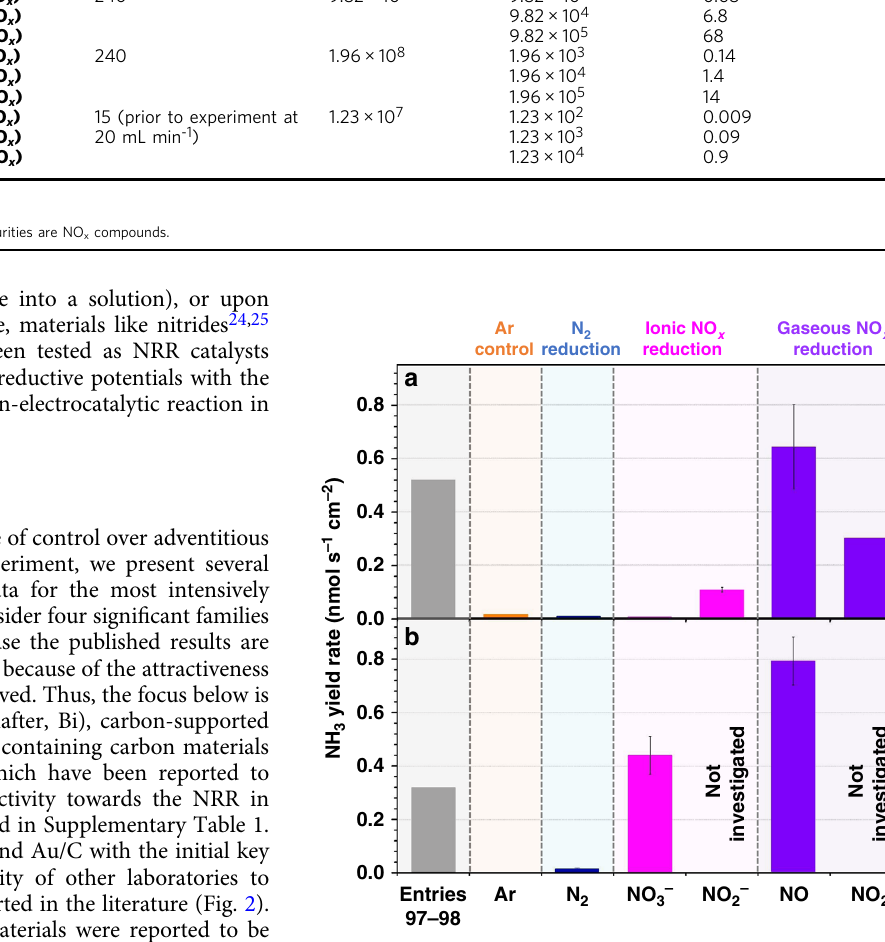
Fig. 2 Bi and Au/C: NRR vs. NO x reduction. Comparison of the NH 3 formation rates for electrodes modi fi ed with a Bi (tested at − 0.65 V vs. reversible hydrogen electrode, RHE) and b Au/C (tested at − 0.30 V vs. RHE) reported in the literature (entries 97 – 98 in Supplementary Table 1) and measured in our laboratory in the presence of Ar, N 2 and different NO x compounds using 0.5 M K 2 SO 4 aqueous electrolyte solutions (for further details, see ref. 4 ). All data are presented as an average ± standard deviation calculated for tests with three independent samples of each